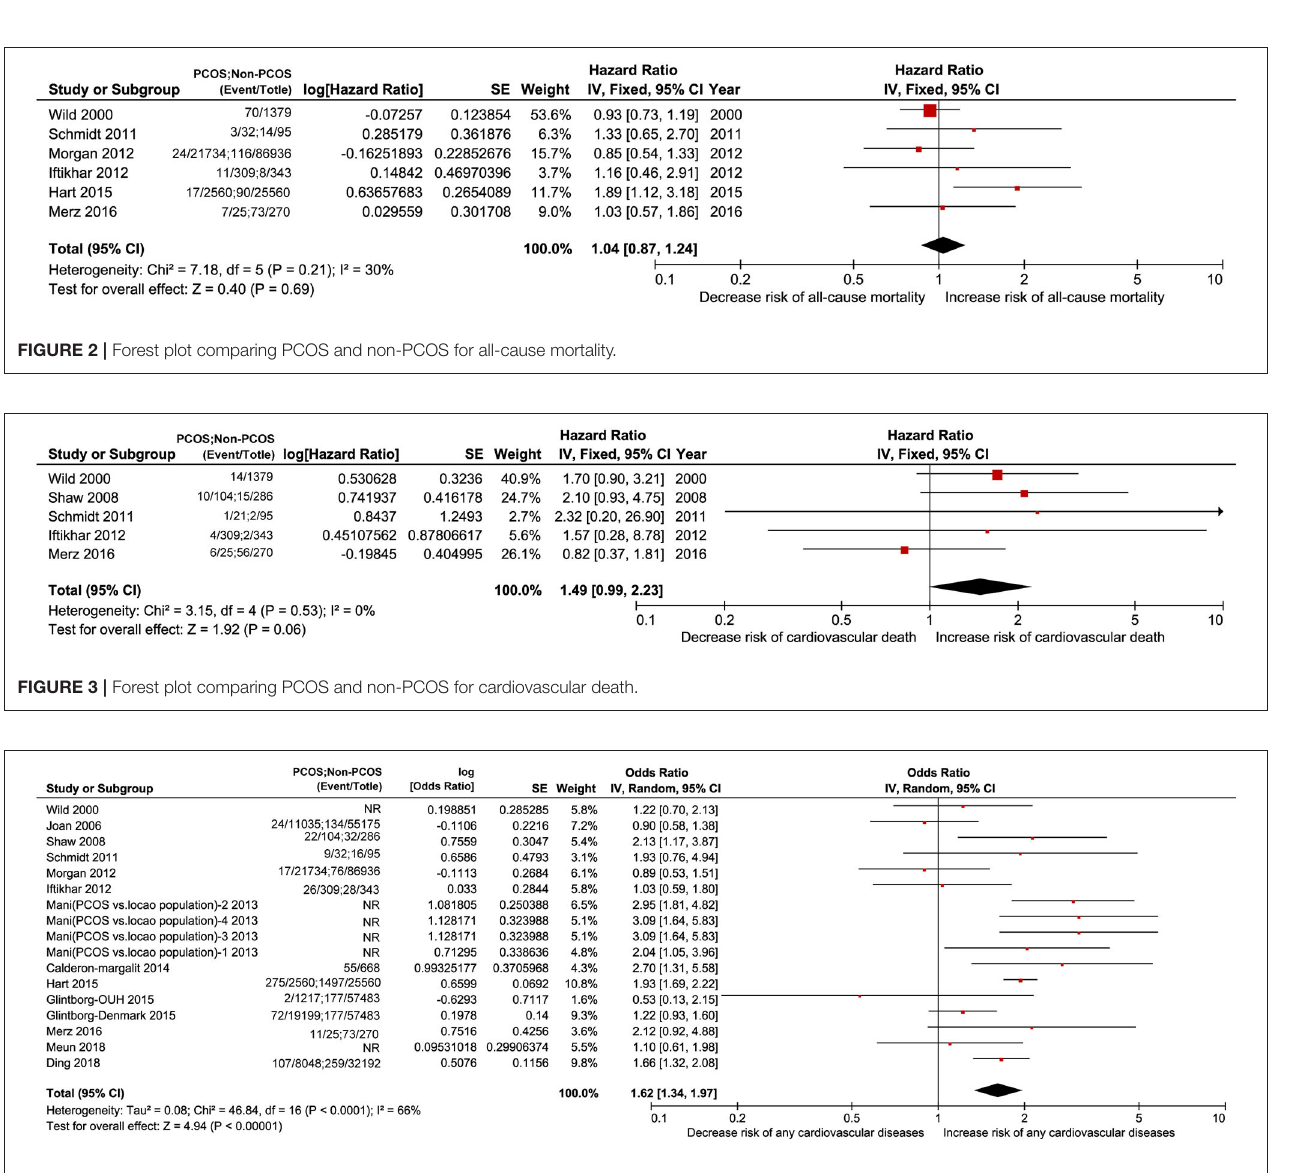
FIGURE 4 | Forest plot comparing PCOS and non-PCOS for any CVDs. NR, not